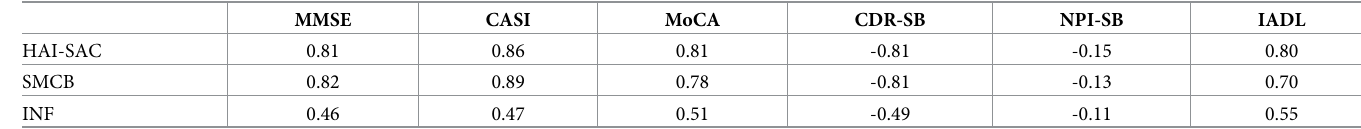
Table 2. Correlations between HAI-SAC and its components and other clinical